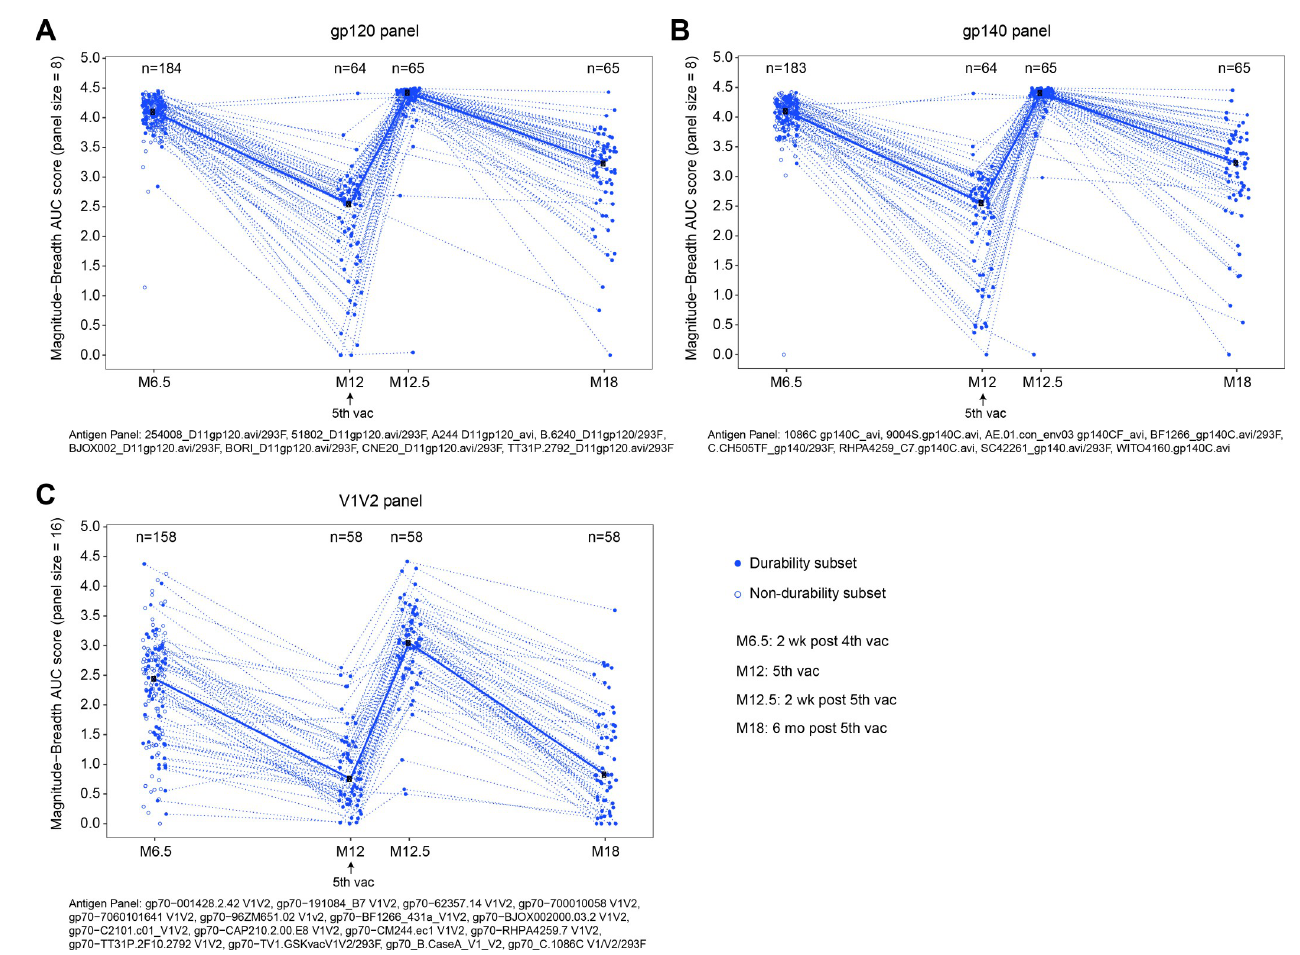
Fig 4. Breadth of IgG binding antibody responses to gp120, gp140, and V1V2 antigens among per-protocol vaccine recipients of HVTN 100. Responses to gp120 (A), gp140 (B), and V1V2 (C) antigens. Each point represents the area under the magnitude–breadth curve for an individual vaccine recipient, calculated as the average of the log 10 (MFI-blank) over the panel of antigens, where antigens are listed in the footnote below each plot. Dashed lines connect the area under the magnitude–breadth curve of each per-protocol vaccine recipient over time. AUC, area under the curve; M[number], month [number]; vac,